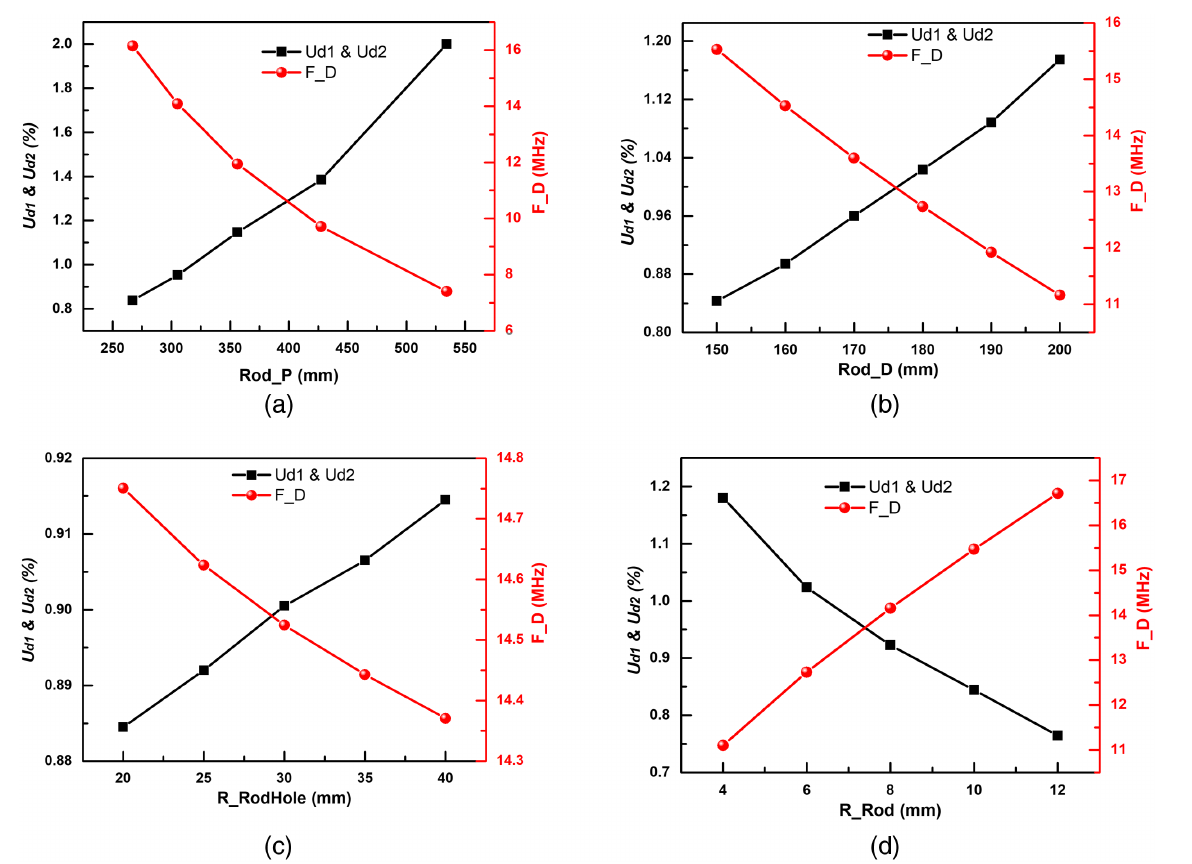
FIG. 9. Effects of PISL geometry parameters [(a) rods period Rod_P; (b) rods distance Rod_D; (c) holes radius R_RodHole; (d) rods radius R_rod] on field asymmetry ( U d 1 and U d 2 ) and frequency differences (F_D) between the operating quadrupole mode and neighboring dipole